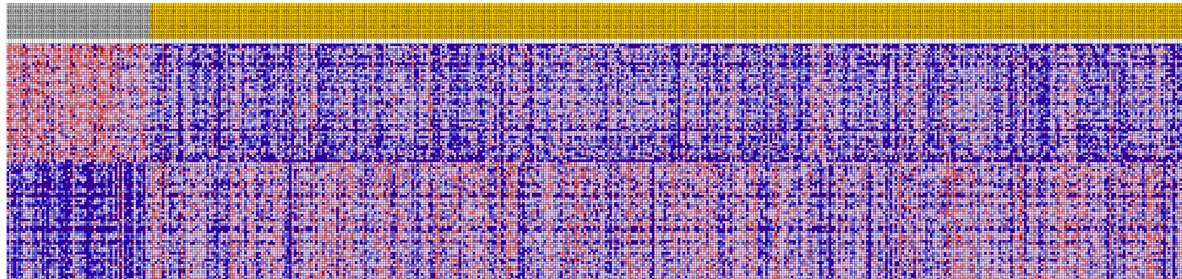
Figure 3: Heat map of the top 100 DEGs. Red: up; purple: down.